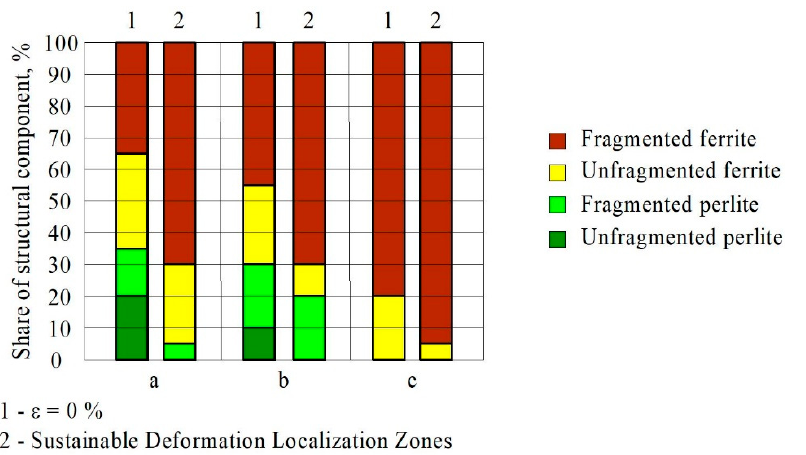
Figure 4. Shares of structural components in the metal of structural steel samples: ( a )—condition without exploitation; ( b )—condition after operation (219 thousand hours) without destruction; ( c )— condition after operation (242 thousand hours) before destruction. The measurement error of each structural component is ±1.5%.